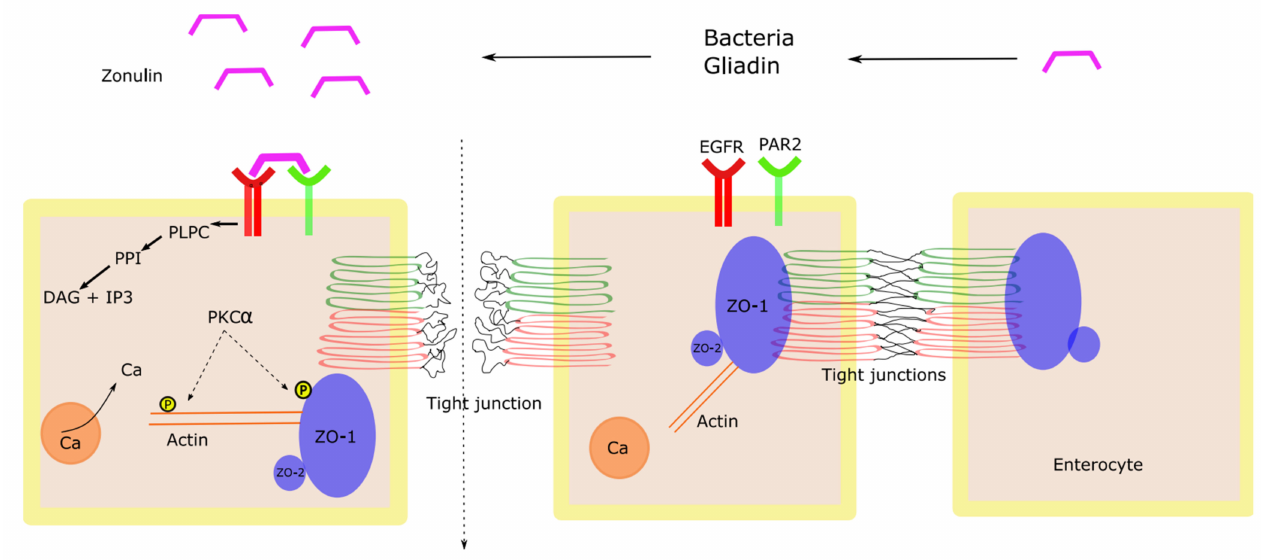
Figure 2. Zonulin-mediated increase in intestinal permeability. EGRF = epidermal growth factor receptor; PAR2 = proteinase-activated receptor 2; PLPC = phospholipase C; PPI = phosphatidyl inositol; DAG = diacylglycerol; IP3 = inositol 1,4,5-tris phosphate; PKC α = Protein kinase C alpha; Ca = calcium; ZO-1 = Zonula occludens-1 ZO-2 = Zonula occludens-2. Prasad et al. [79] (published as preprint manuscript) examined the plasma microbiome trols. At the phylum level, Proteobacteria was highest in all samples (22%–91%),